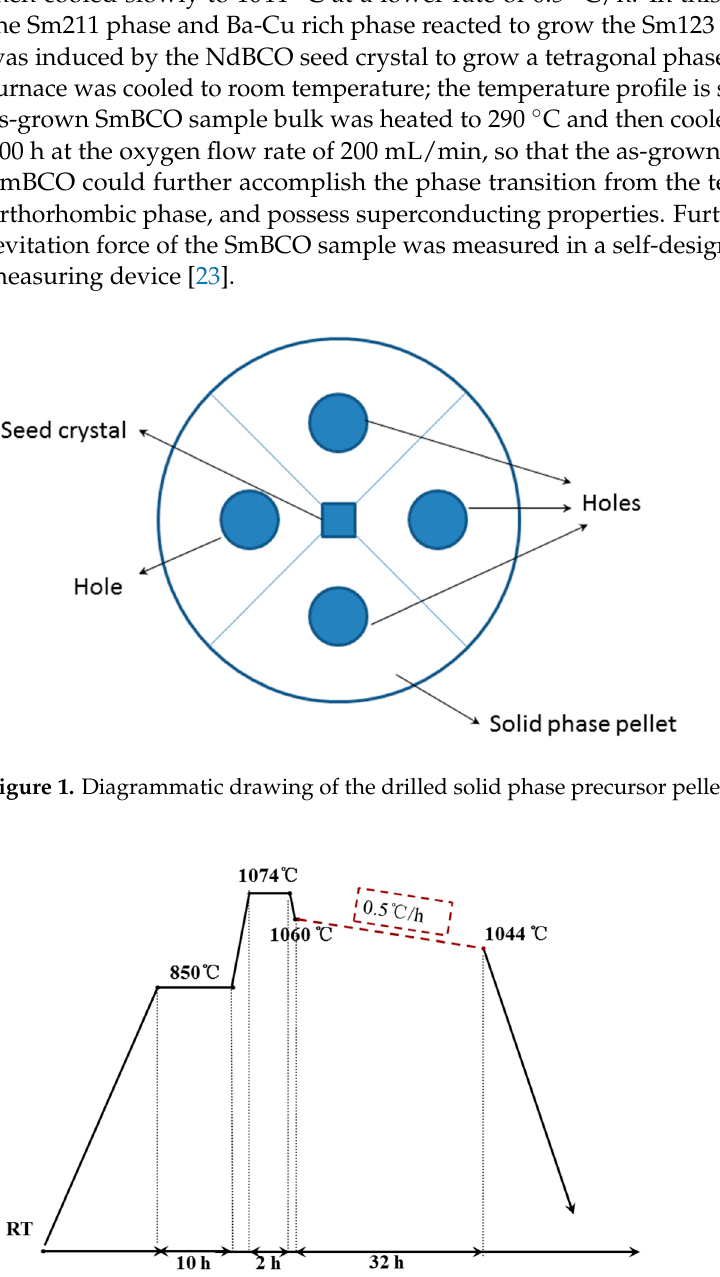
Figure 1. Diagrammatic drawing of the drilled solid phase precursor pellet.